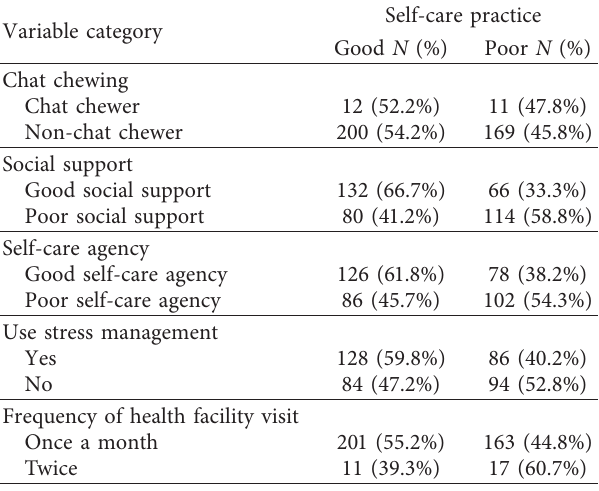
Table 3: The behavioral related health profiles of hypertensive patient on Debre Tabor Referral Hospital, Northwest